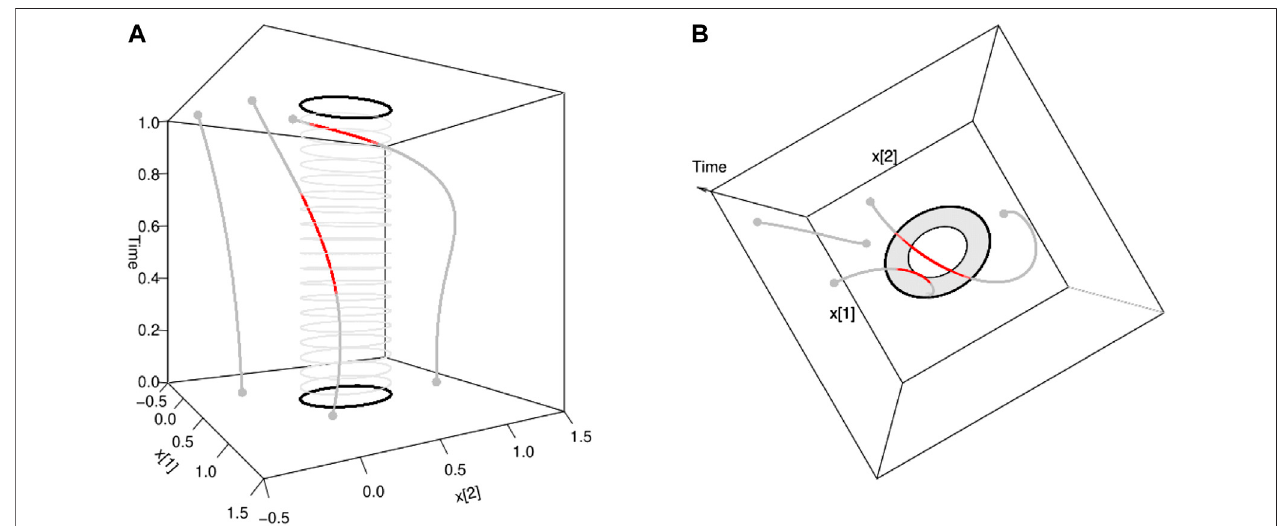
FIGURE2| Illustrationofcontact-based,duration-basedandlength-basedpointwise connectivities: Ψ C , Ψ D and Ψ L arebetweentheellipticspatialdomain A ⊂ R 2 and different spatial points x at time s (cid:1) 1, for Δ ts (cid:1) [ 0 , 1 ] . The left curve on panel (A) never enters the domain A . The middle curve on panel (A) enters A (red part of the curve)overarelativelylongduration[asshownbyPanel (B) ]butashortdistance[asshownbyPanel (B) ].Therightcurveonpanel (A) enters A overashorterdurationbut alongerdistance.Thus, Ψ C ( A | t , s , x ) , Ψ D ( A | t , s , x ) and Ψ L ( A | t , s , x ) arezero forthe leftcurve; Ψ C ( A | t , s , x ) (cid:1) 1 forthetwo othercurves; Ψ D ( A | t , s , x ) islargerfor the middle curve than for the right one, whereas Ψ L ( A | t , s , x ) is larger for the right curve than for the middle